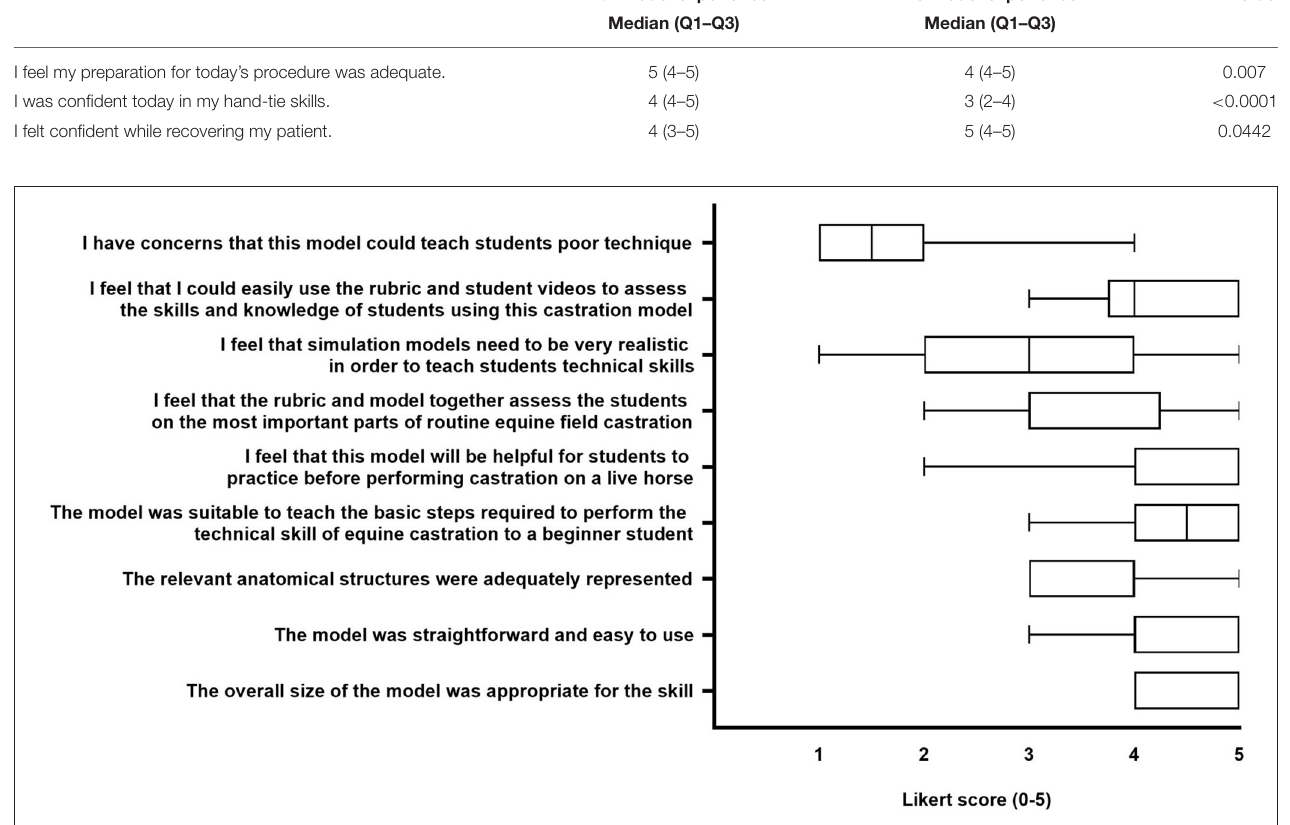
FIGURE 7 | Survey results of expert veterinary evaluation of the low-fidelity equine castration model. Data are presented as median and min-max.